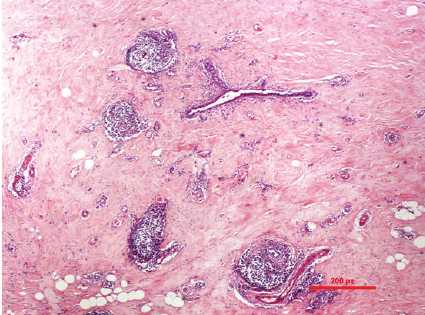
Figure 3: Microscopic images showing marked fibrosis and keloid- like hyalinization of interlobular stroma.